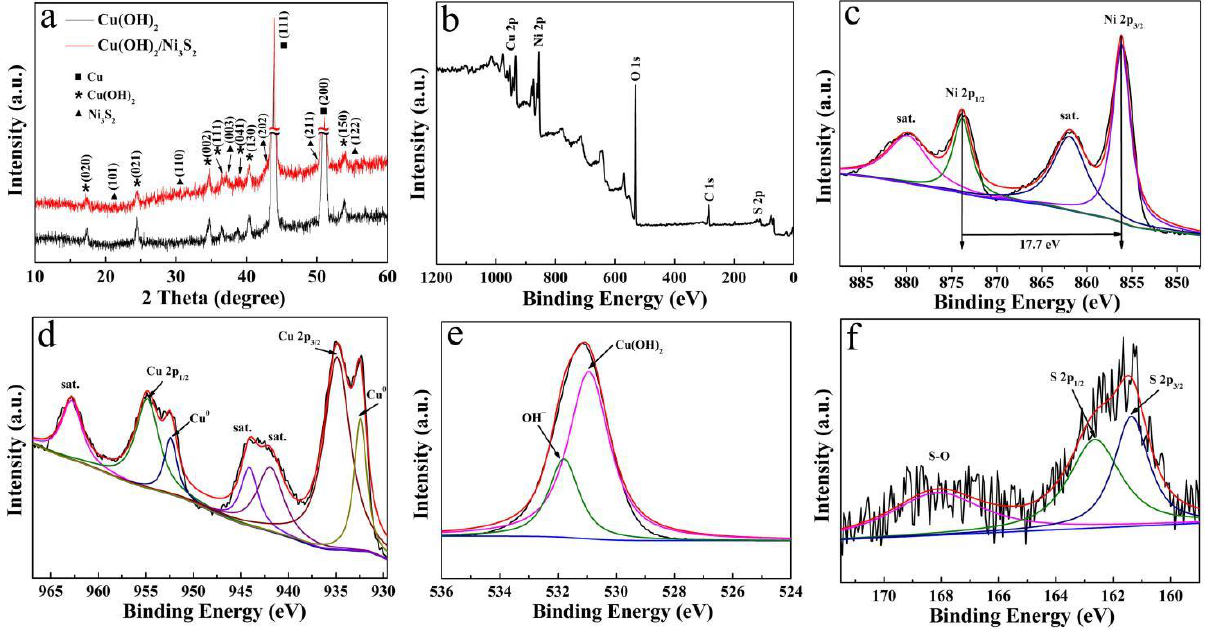
Figure 4. XRD patterns of Cu(OH) 2 and Cu(OH) 2 /Ni 3 S 2 ( a ). XPS spectra of Cu(OH) 2 /Ni 3 S 2 : survey scan ( b ), Ni 2p ( c ), Cu 2p ( d ), O 1s ( e ), and S 2p ( f ). scan ( b ), Ni 2p ( c ), Cu 2p ( d ), O 1s ( e ), and S 2p ( f